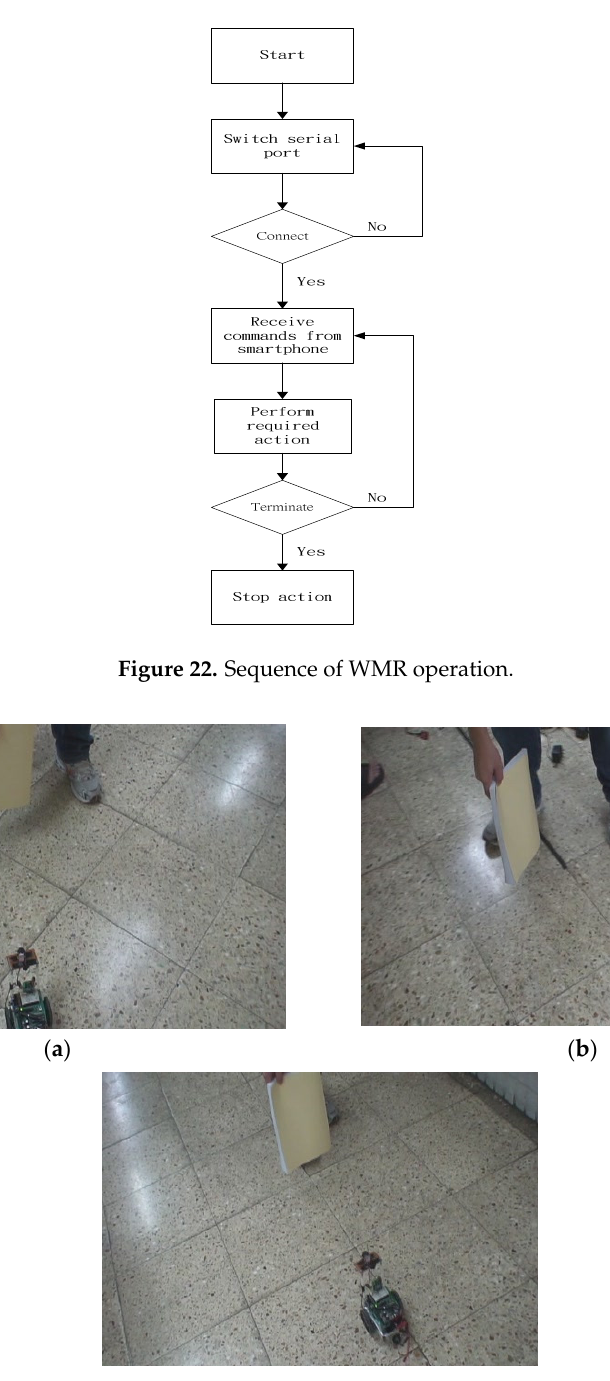
Figure 21. Sequence of smartphone operation.